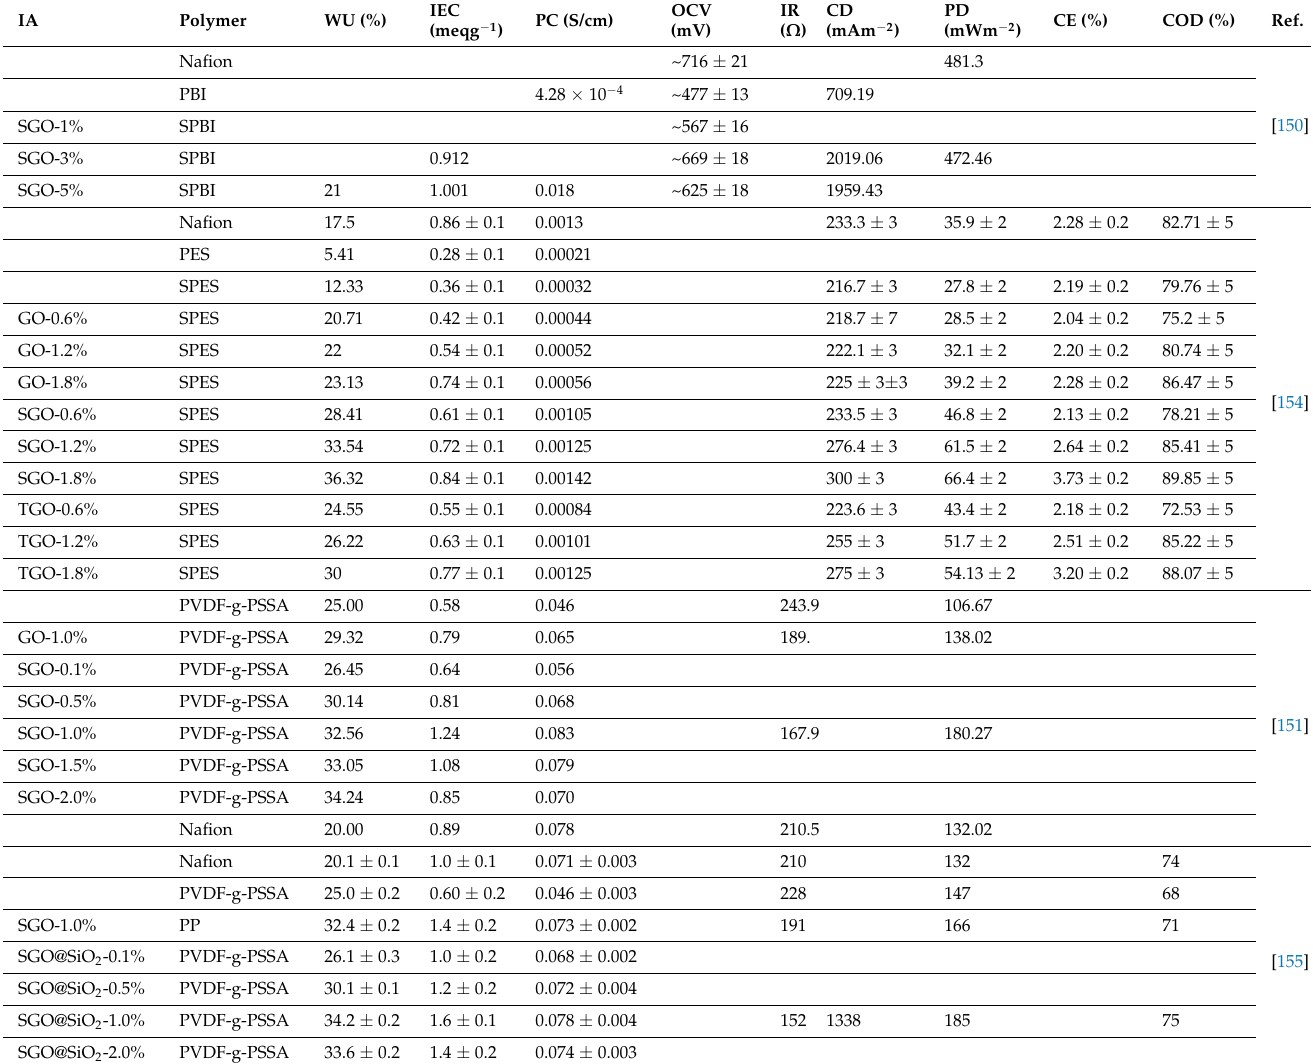
Table 3. Physicochemical properties and performance evaluation results of sulfonated graphene oxide containing polymer membrane for MFC